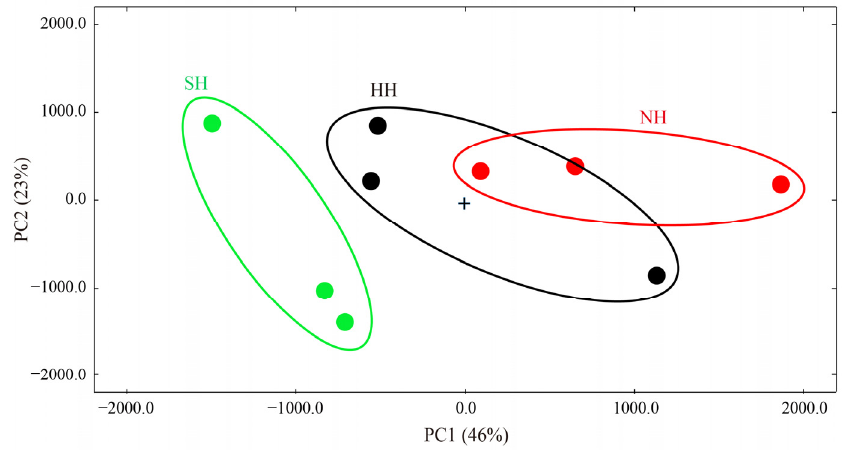
Figure 6. PCA of volatile flavor compounds in F 1 crossbred lambs.